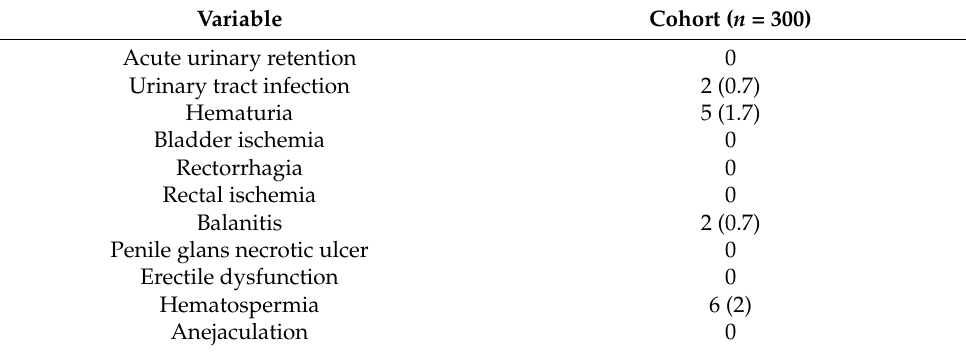
Table 4. Embolization-related adverse